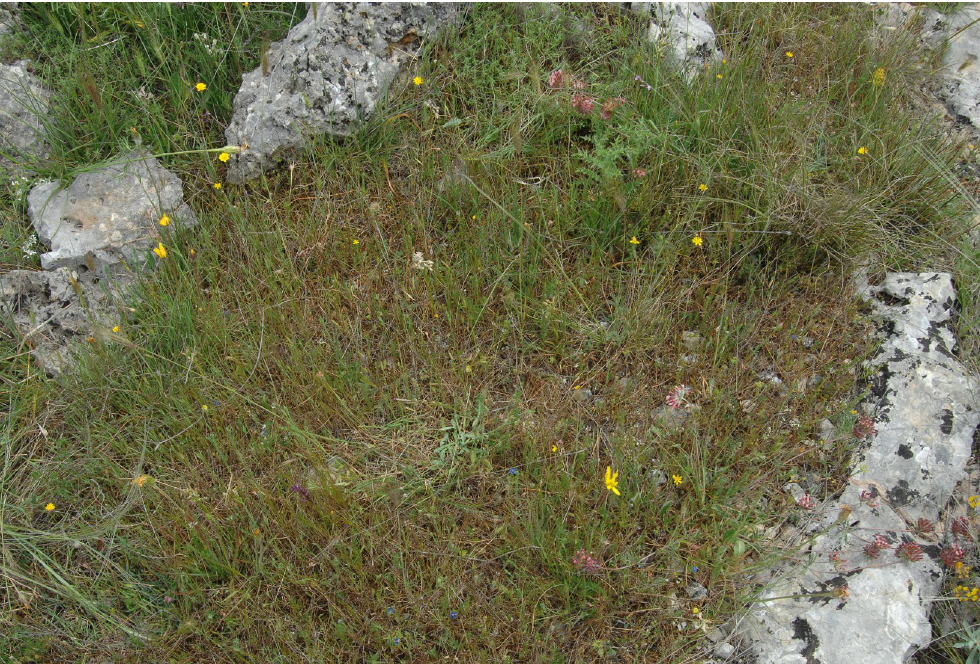
Figure 5. Euphorbio exiguae-Ophioglossetum lusitanici ass. nova hoc loco. Date: 3 May 2021, Santeramo in Colle, in loc. Alessandrelli (Bari). Photo by Enrico Vito Perrino.